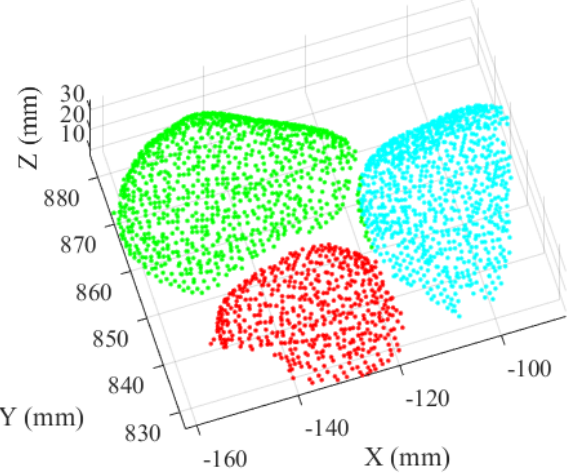
Figure 7. Performance of particle recognition.